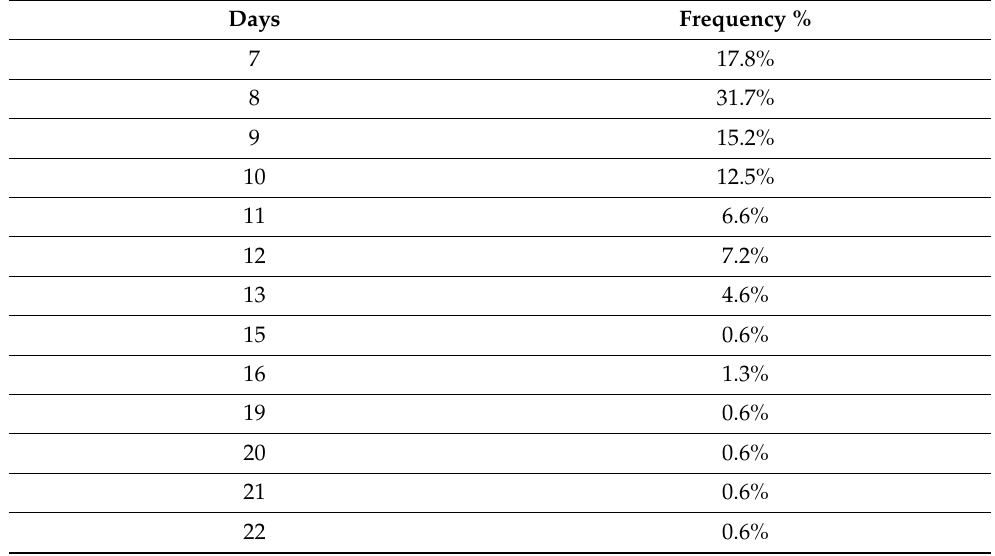
Table 2. Frequency of days required to record a full valid 7-day observation period.